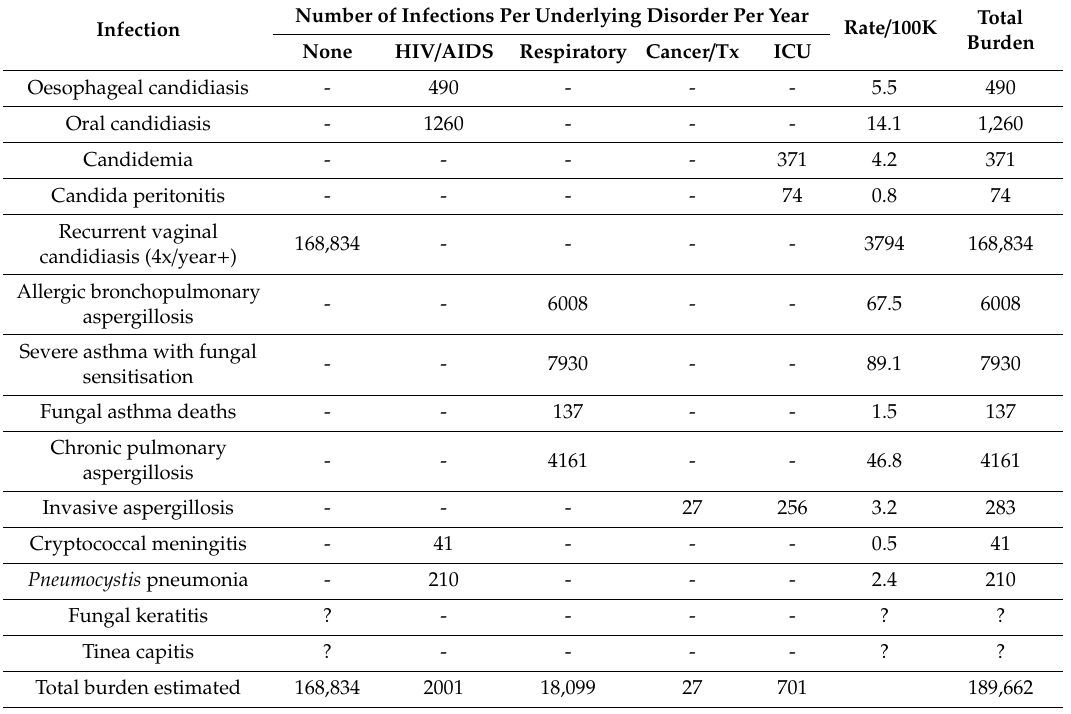
Table 1. The burden of serious fungal infections in